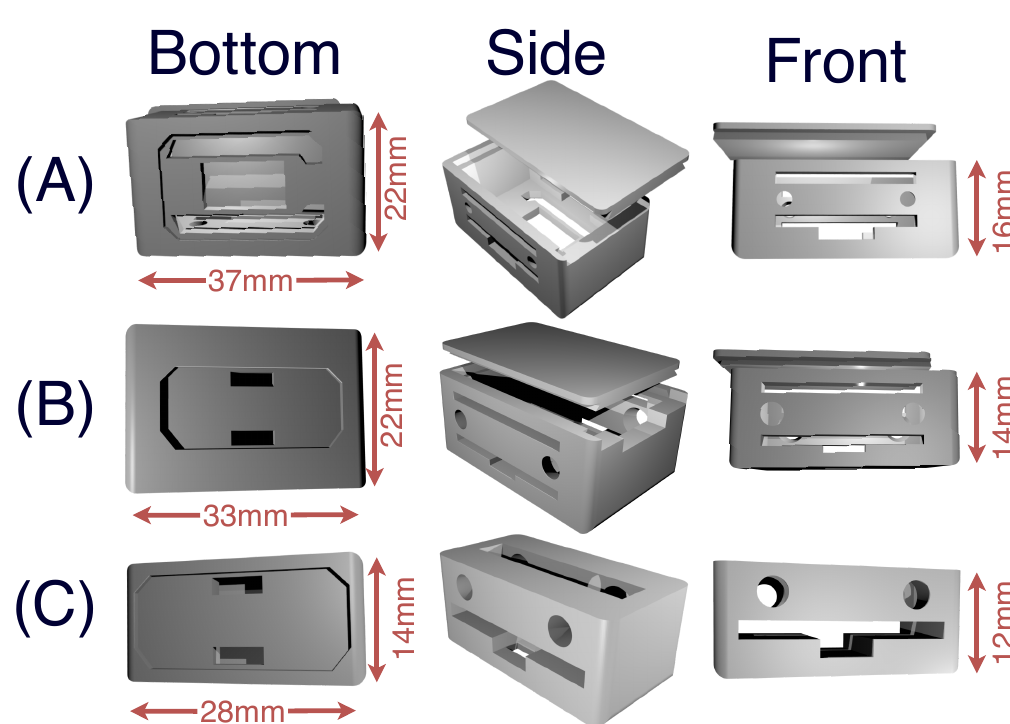
Figure 5. ( A ) The system’s receptacle: The bottom of the unit is used to receive the main electrode, while the system is stored inside. A cover slides on to enclose the system. ( B ) The battery holder: This receptacle is used to house the power source of the armband and, as such, should be placed next to the system’s holder. Once the battery is placed, the cover can then slide on to protect the system. A standard electrode is placed on the bottom of this holder. ( C ) This holder houses a standard